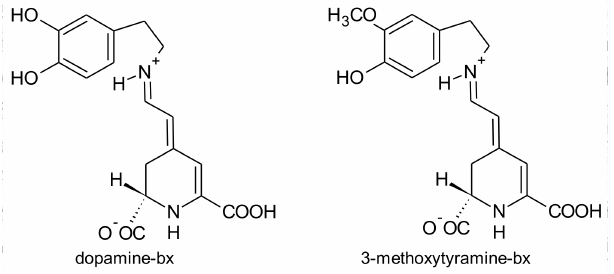
Figure 7. Betaxanthins found in Alternanthera brasiliana and Alternanthera tenella